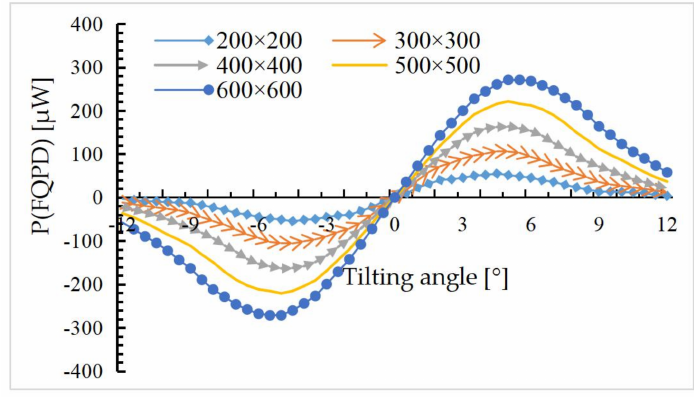
Figure 11. P α over α for different PD areas at h = 2